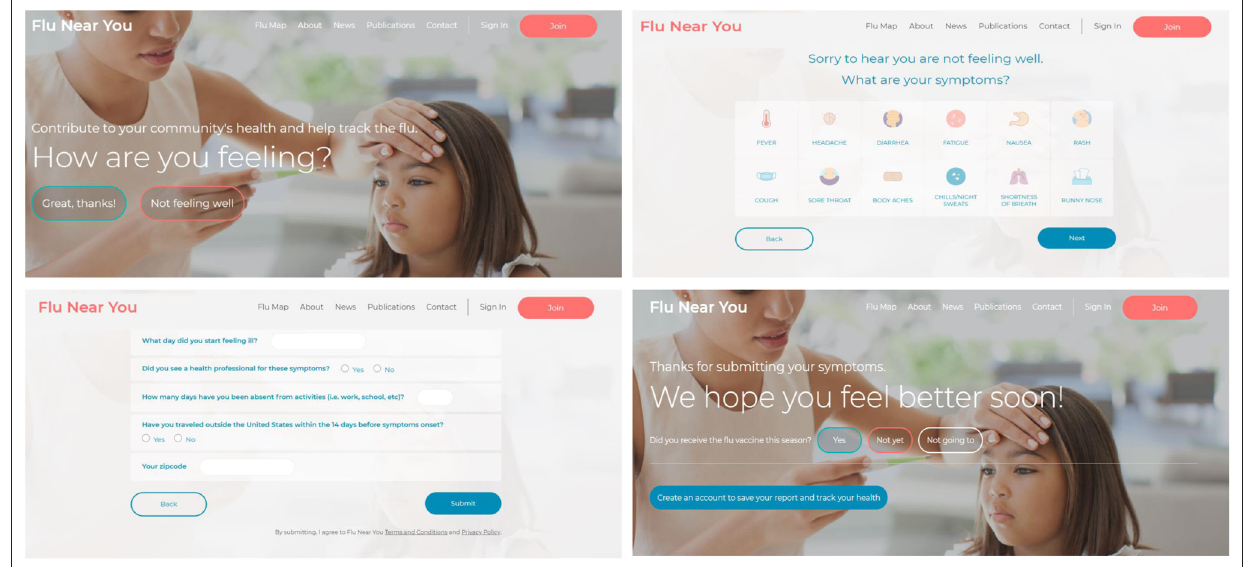
Figure 1 Screenshots of Flu Near